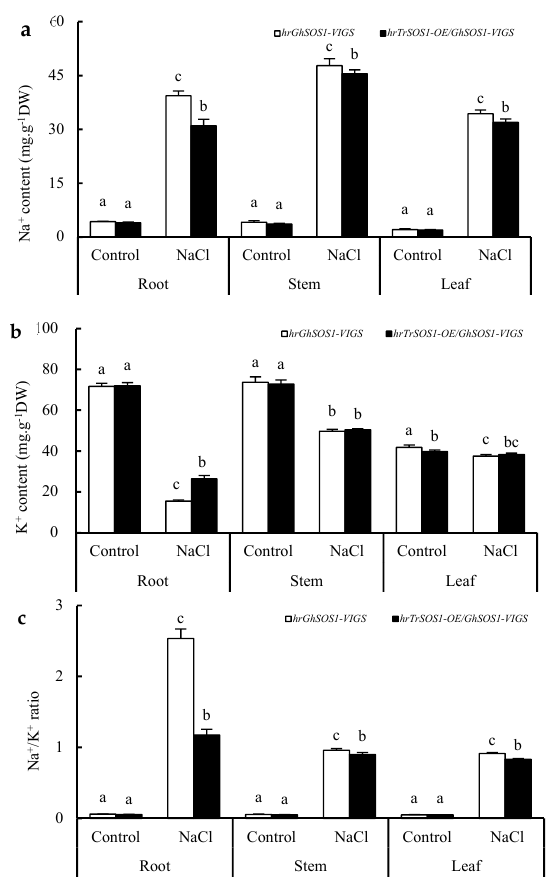
Figure 4. Effect of salt stress on contents of Na + ( a ), K + ( b ), and Na + /K + ratio ( c ) in the roots, stems, and Figure 4. E ff ect of salt stress on contents of Na + ( a ), K + ( b ), and Na + / K + ratio ( c ) in the roots, stems, leaves of hairy root composite cotton plants of hrGhSOS1 -VIGS or hrTrSOS1 -OE/ GhSOS1 -VIGS. and leaves of hairy root composite cotton plants of hrGhSOS1 -VIGS or hrTrSOS1 -OE / GhSOS1 -VIGS. Int. J. Mol. Sci. 2019 , 20 , x FOR PEER REVIEW Different lowercases in the same group indicate the significant differences ( p ≤ 0.05). Di ff erent lowercases in the same group indicate the significant di ff erences ( p ≤ 0.05).